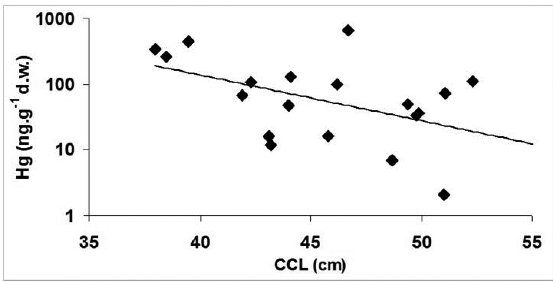
Figure 3. Significant negative correlation (n=19; p<0.05) between total Hg concentrations and curved carapace length (CCL) of living juvenile individuals of C. mydas from the Ceará coast in NE